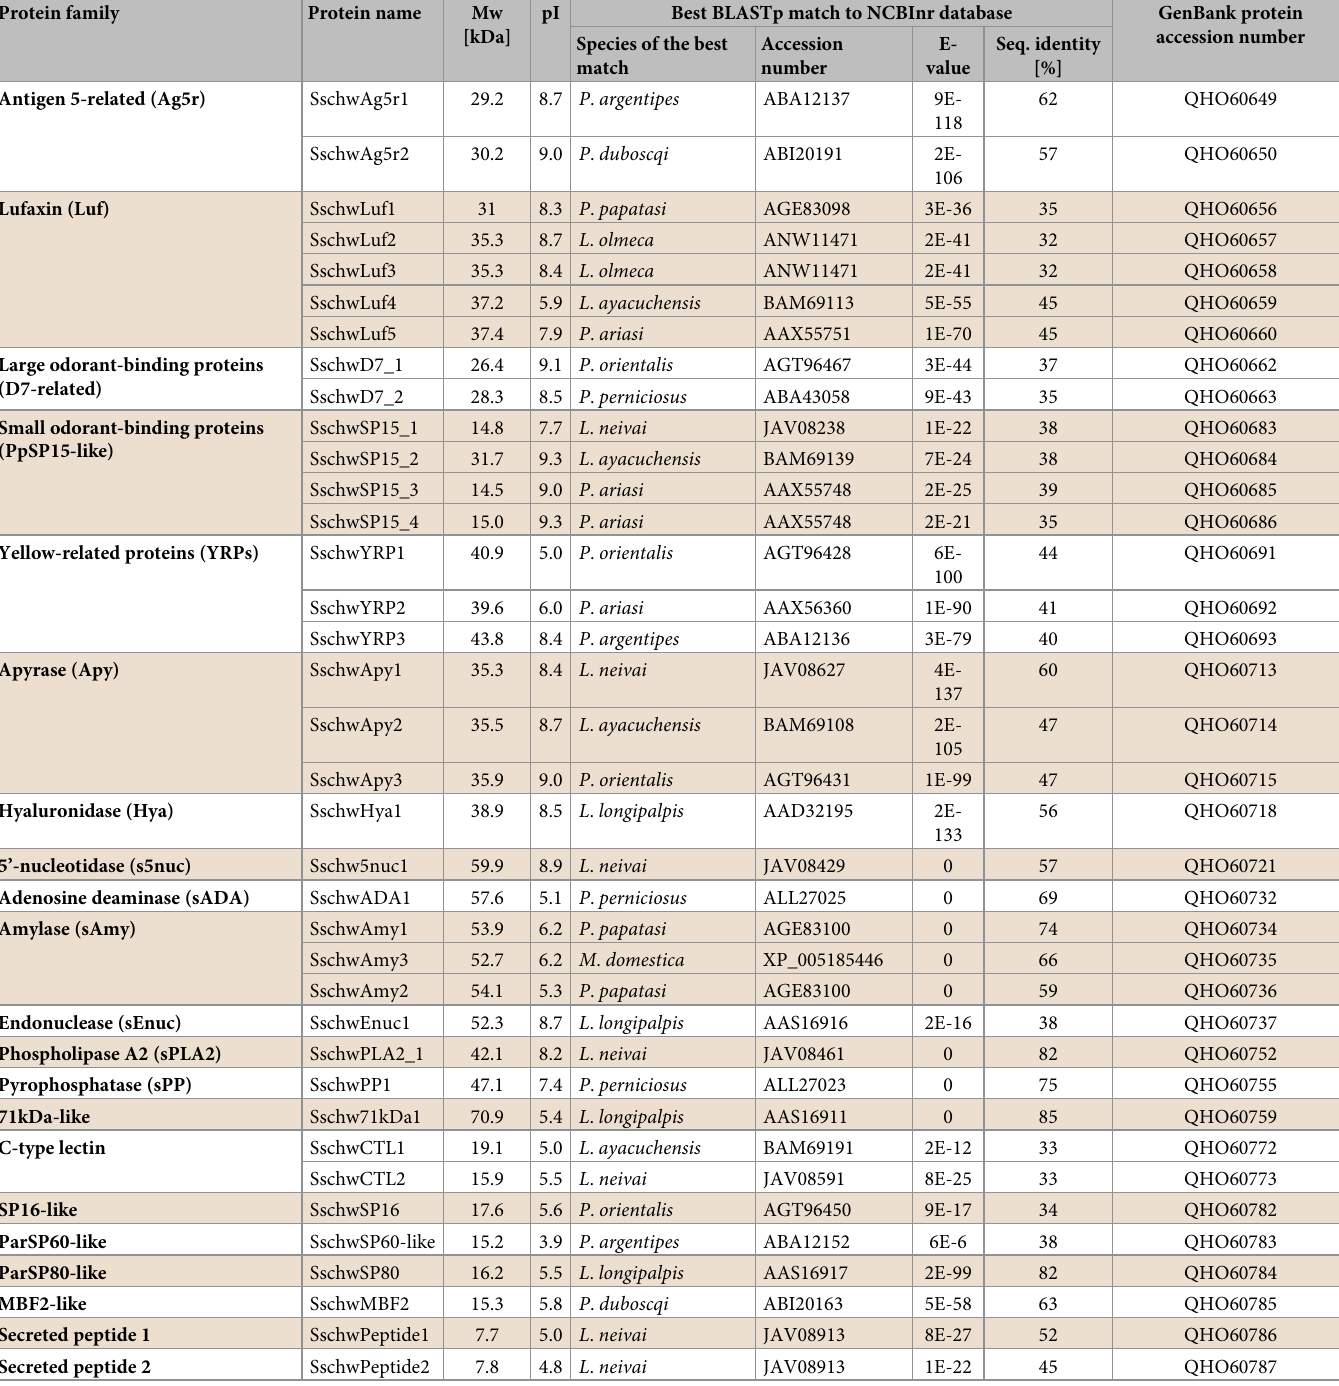
Table 1. Main salivary protein families identified in the transcriptome of S . schwetzi . Protein